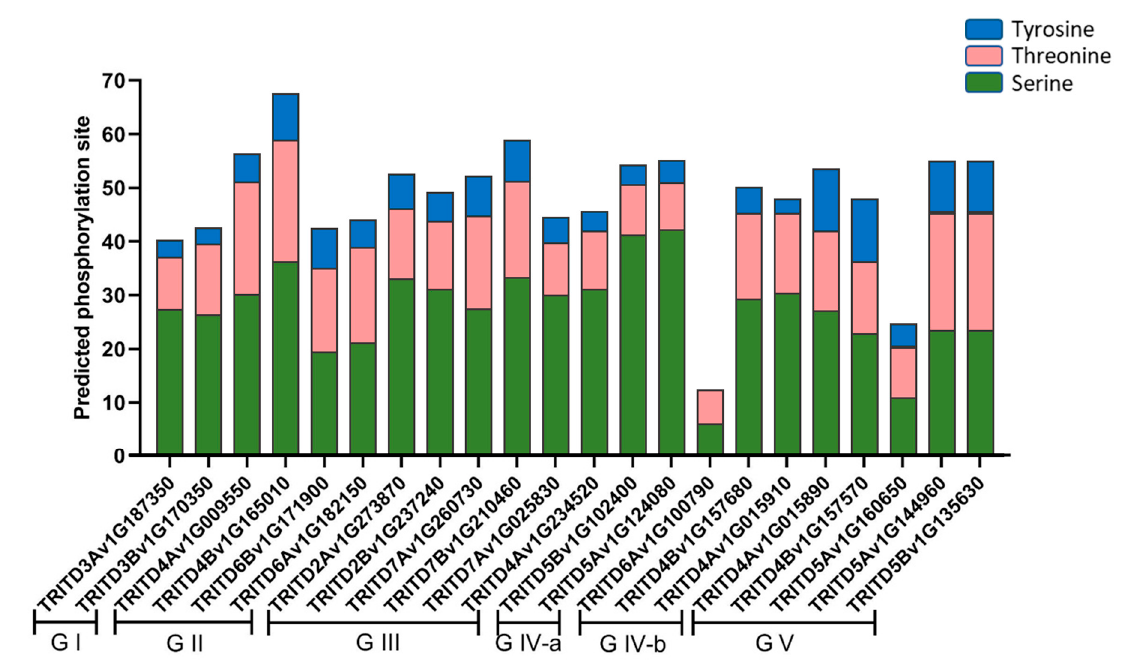
Figure 4. Prediction of phosphorylation sites in Td SULTR proteins based on three amino acids including serine, tyrosine, and threonine. Td SULTR is separated according to the phylogeny tree from G I (group 1) to G V (group 5).